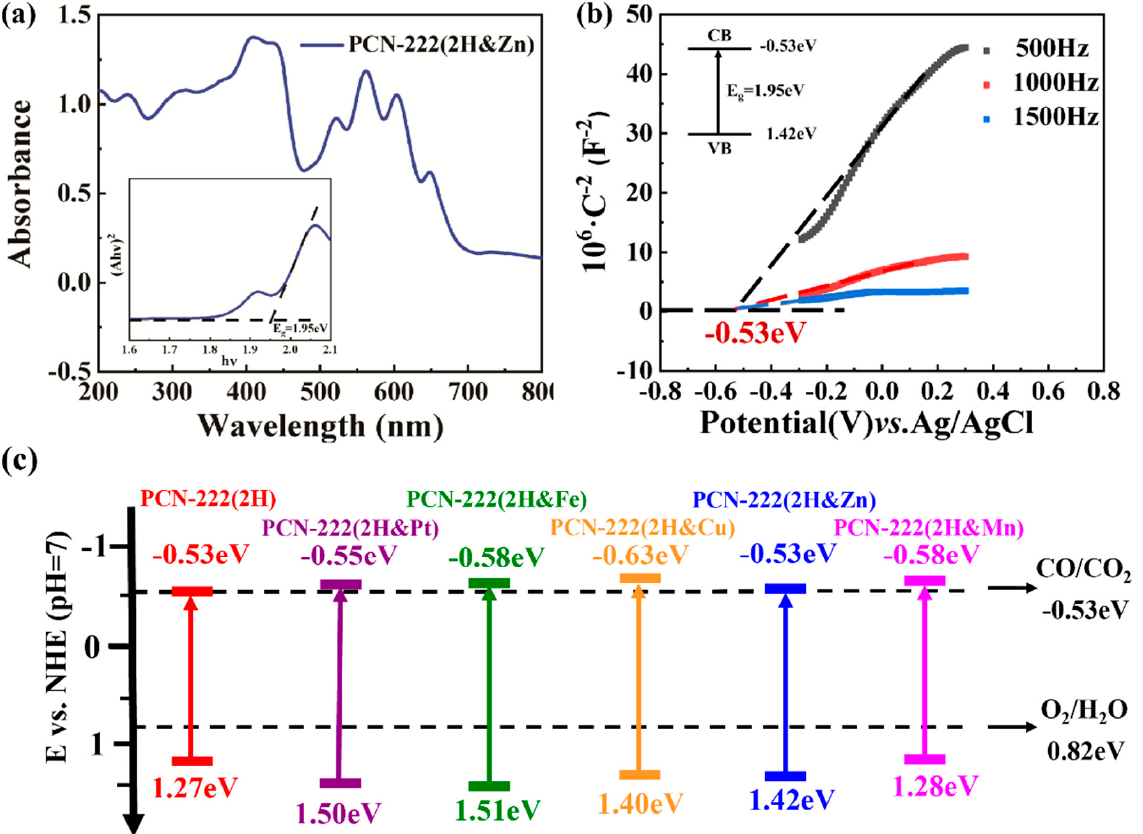
Figure 4. ( a ) UV–vis diffusion spectra and Tauc plot of PCN − 222(2H&Zn), ( b ) Mott–Schottky plots of PCN − 222(2H&Zn), and ( c ) calculated redox potentials of PCN − 222(2H) and PCN − 222(2H&M).